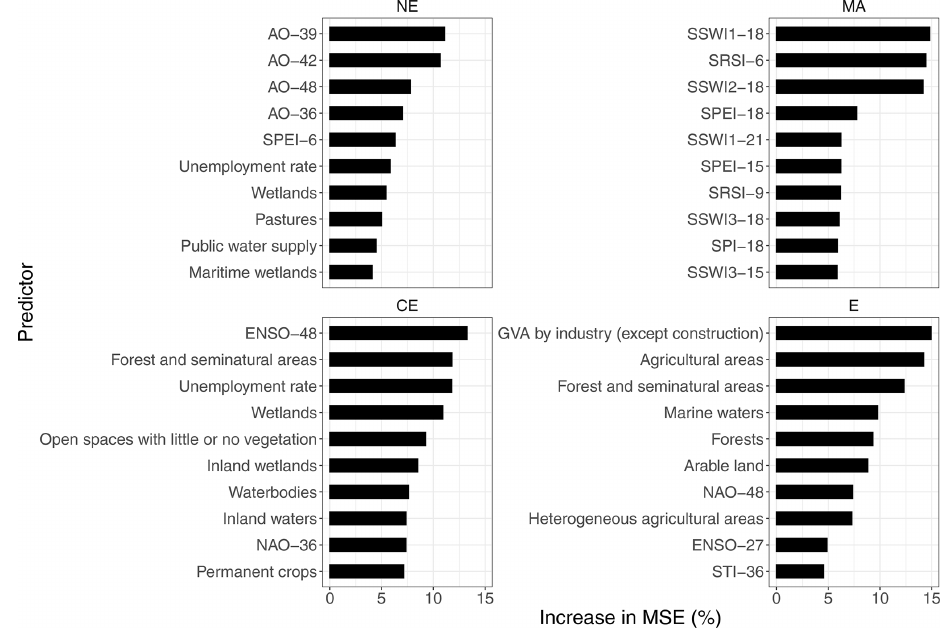
Figure 11. Predictor importance when using regression random forest models built with vulnerability factors in addition to the drought indices. Counting method CM1 is used. Models are built with data from